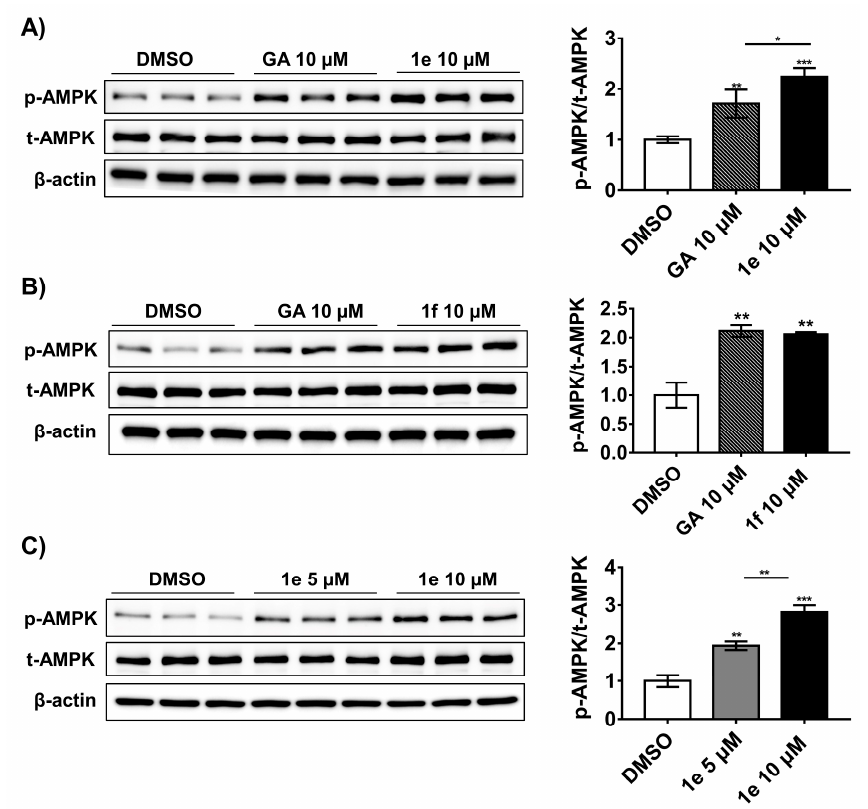
Figure 5. Compound 1e increased AMPK activation in mature 3T3-L1 adipocytes. ( A , B ) Immunob- lot analysis of p-AMPK levels in 3T3-L1 adipocytes following treatment with GA, 1e, and 1f at 10 µM ( C ). Immunoblot analysis of p-AMPK levels in 3T3-L1 adipocytes following treatment with compound 1e at the indicated concentrations. The densities of the corresponding bands were quantified using deviation ( n = 3). * p ≤ 0.05, ** p ≤ 0.01, and *** p ≤ 0.001 vs. Control DMSO. Statistical analysis